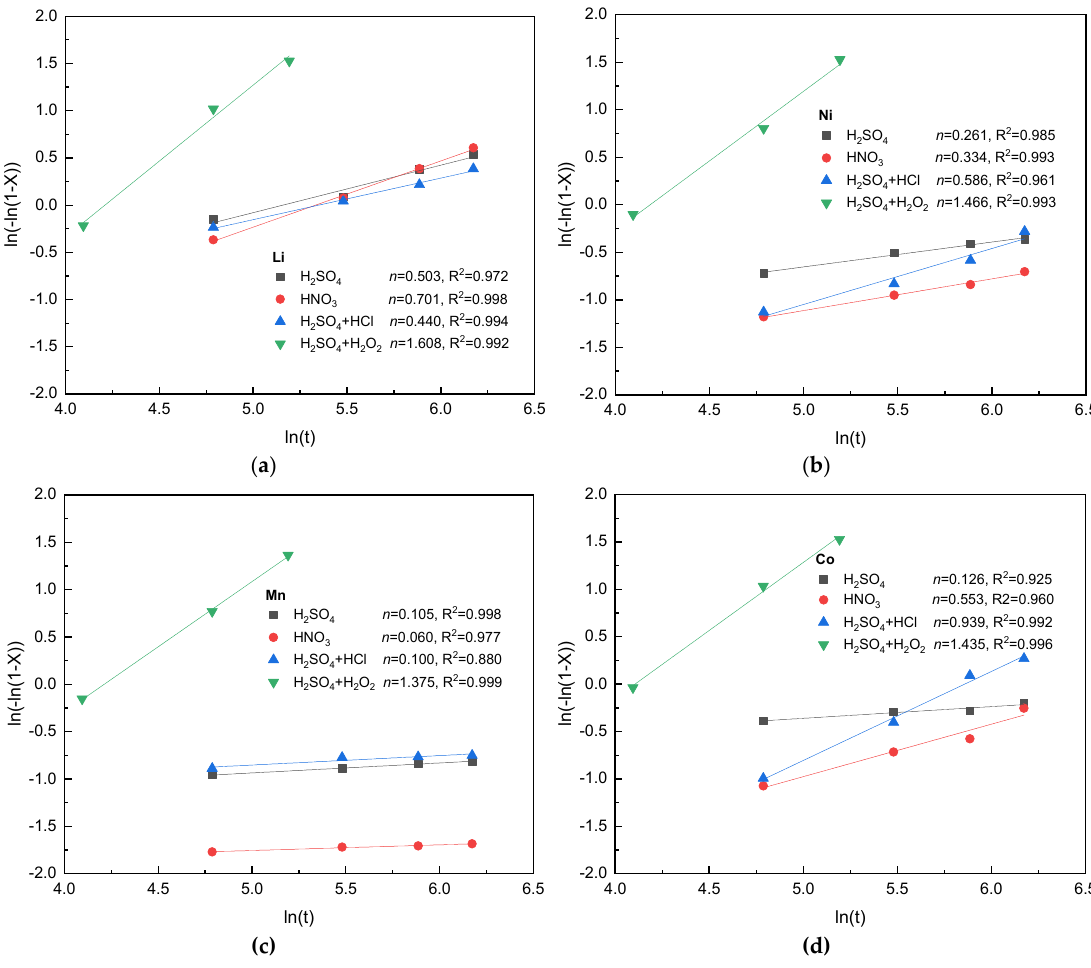
Figure 6. Plots of ln( − ln(1 − X)) to ln(t) of ( a ) lithium, ( b ) nickel, ( c ) manganese, and ( d ) cobalt in different acids (leaching conditions: acid molarity: 4 N; solid/liquid: 1:15 w/v ; 65 °C and 480 min; except for H 2 SO 4 + H 2 O 2 at 50 °C and 180 min).